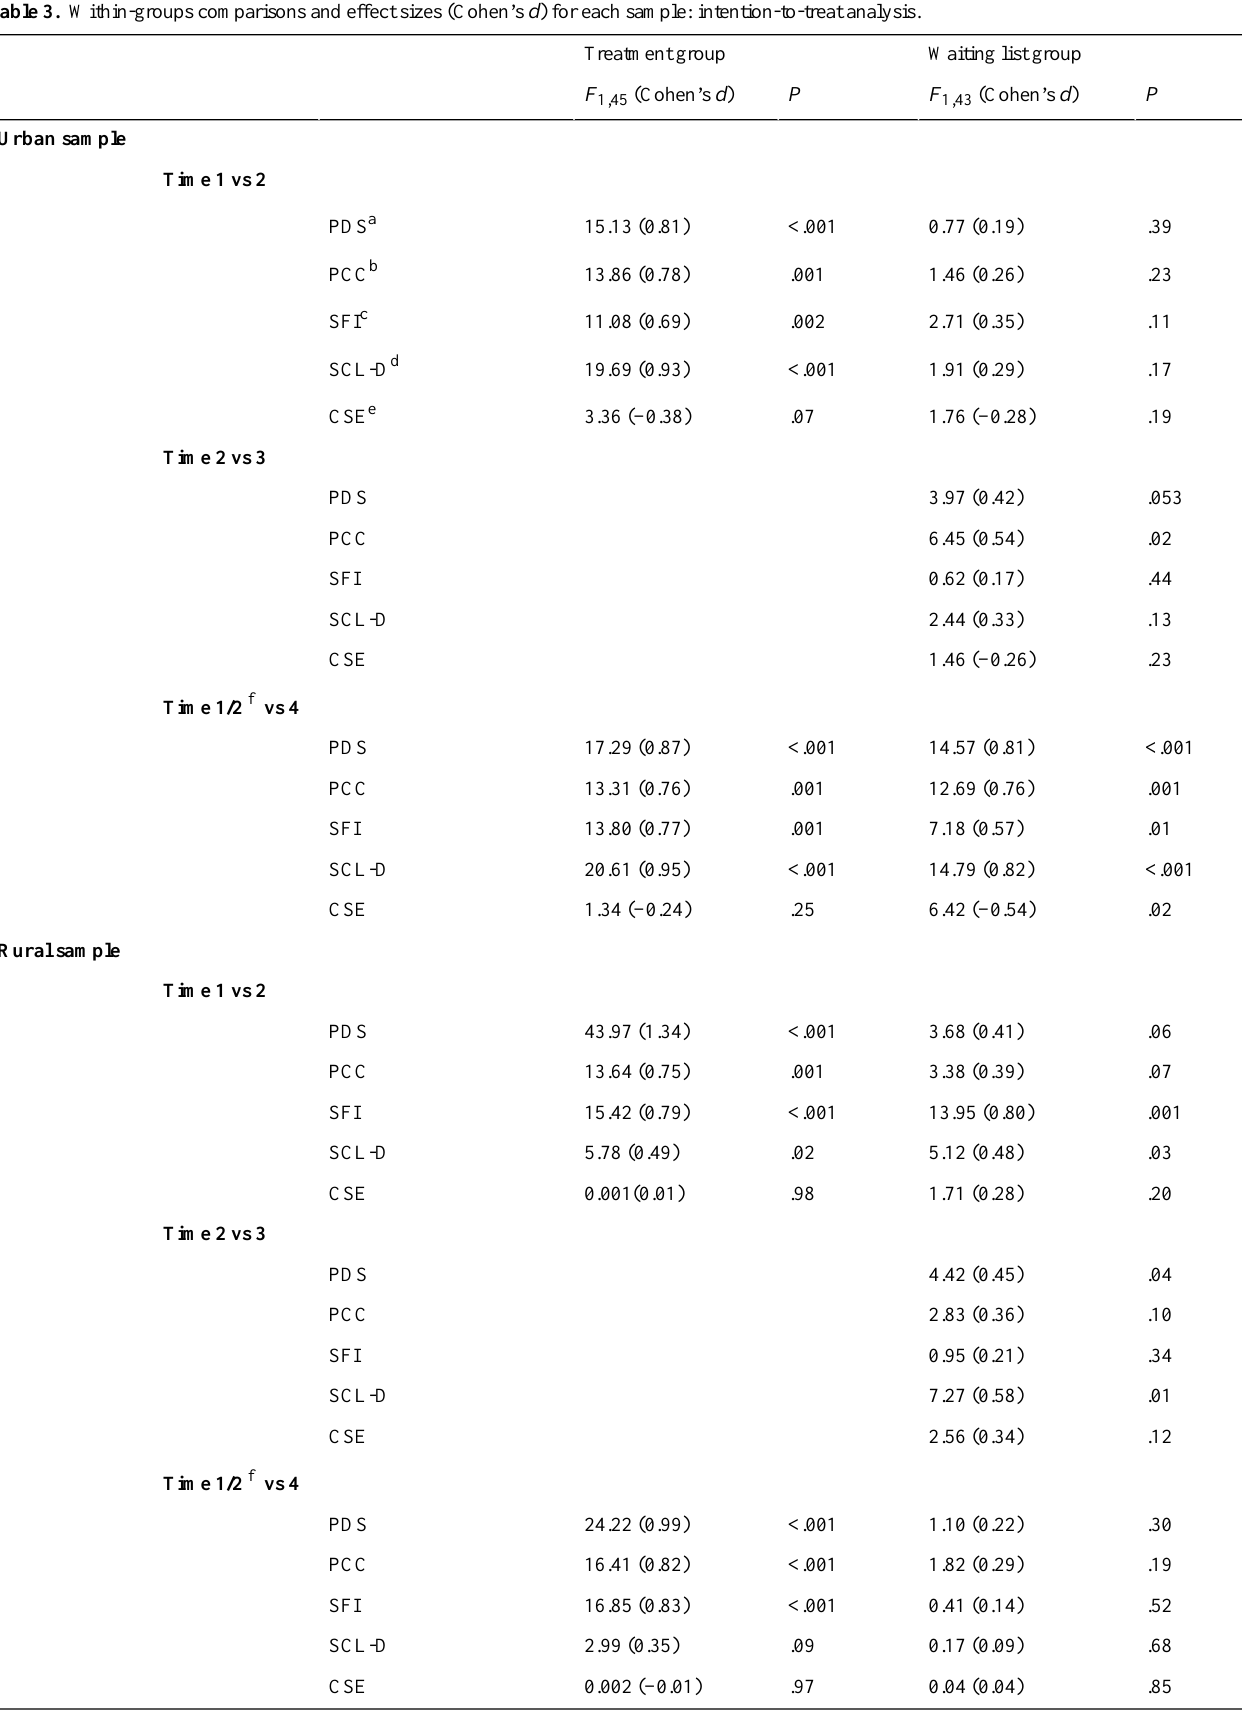
Table 3. Within-groups comparisons and effect sizes (Cohen’s d ) for each sample: intention-to-treat analysis.